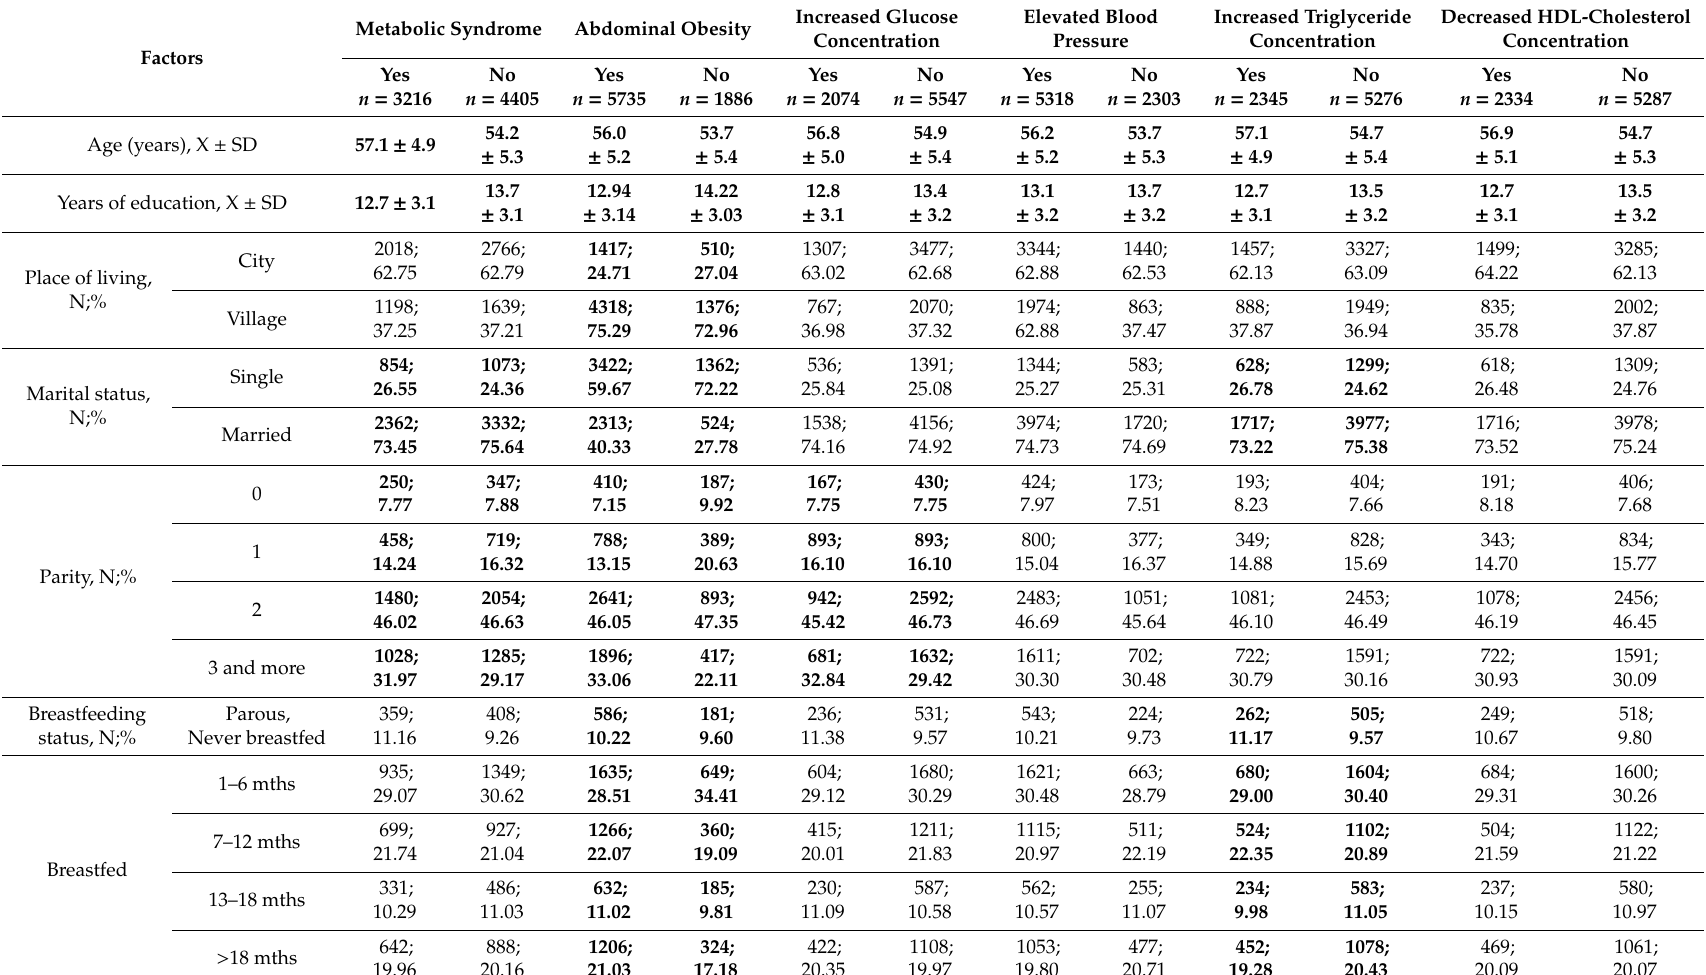
Table 1. Baseline characteristics of the study population ( n =